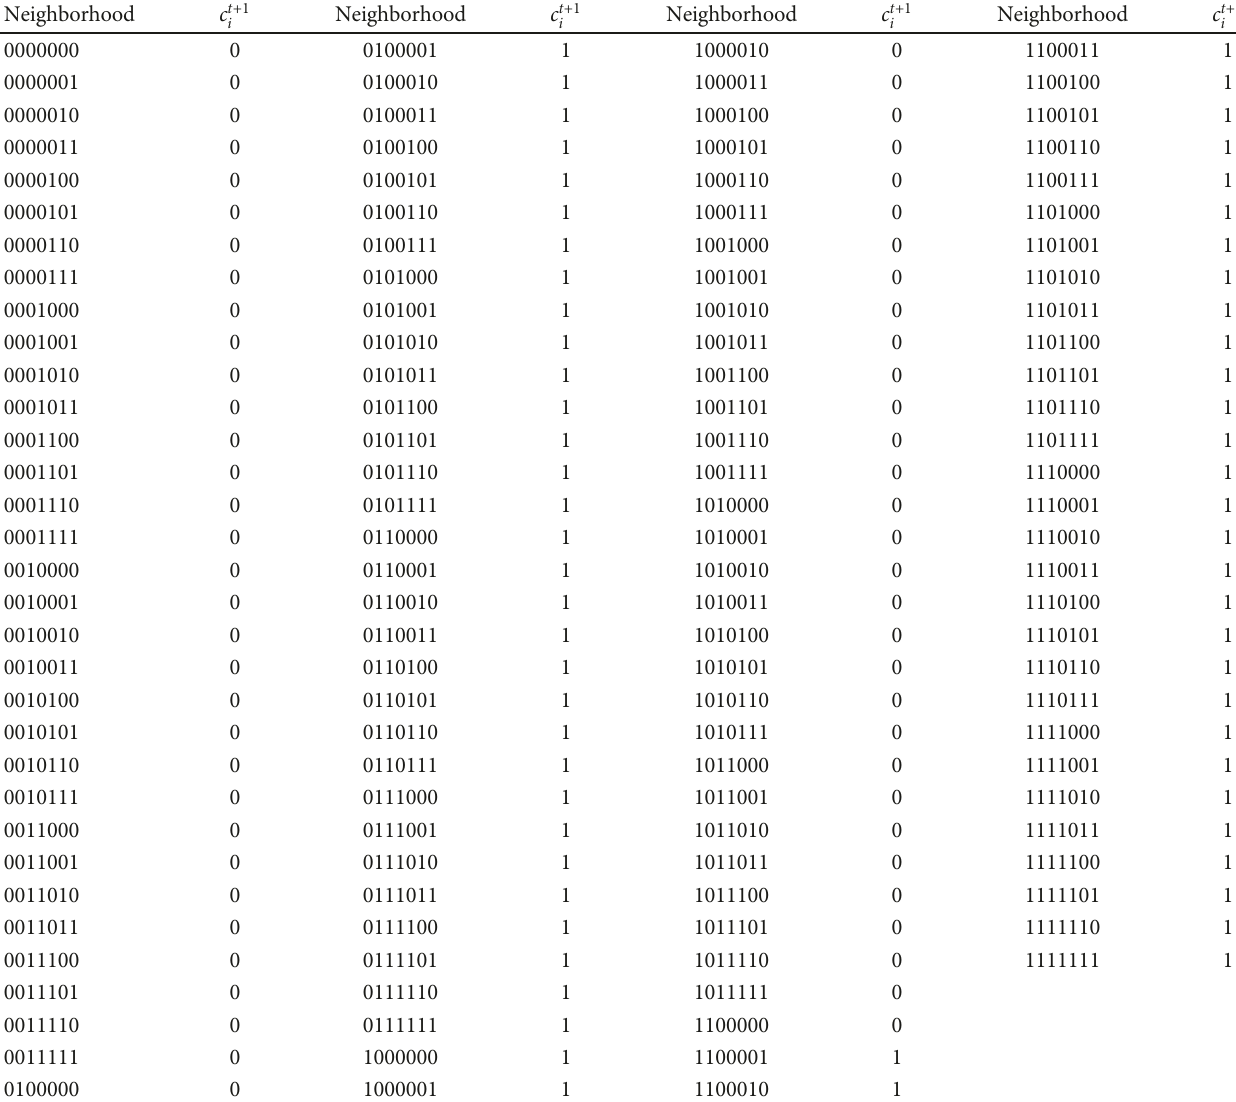
= φ c t c t c t , ⋯ , c t c t i i − 1 i i +1 j − 1 j